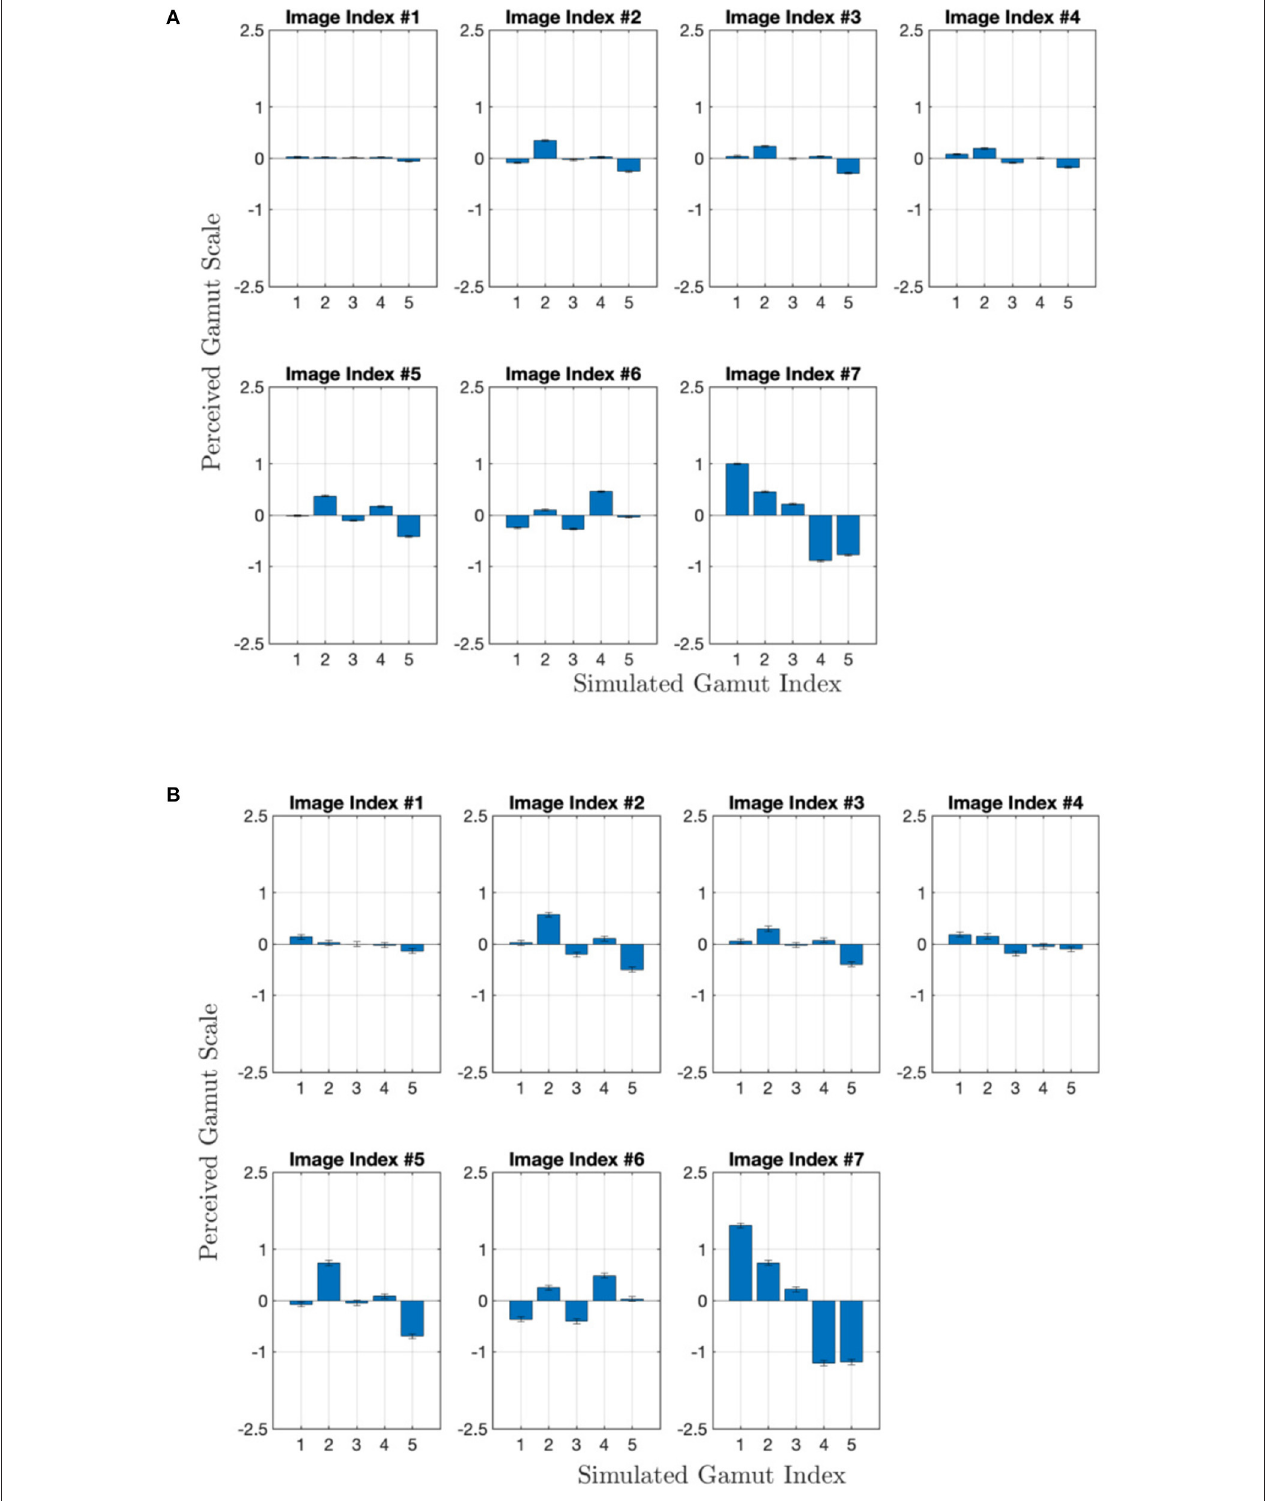
FIGURE 5 | Perceived CGV scales, derived from all 33 observers (A) the subset of 11 observers (B) , vs. different gamuts. Each panel corresponds to one image content’s results.